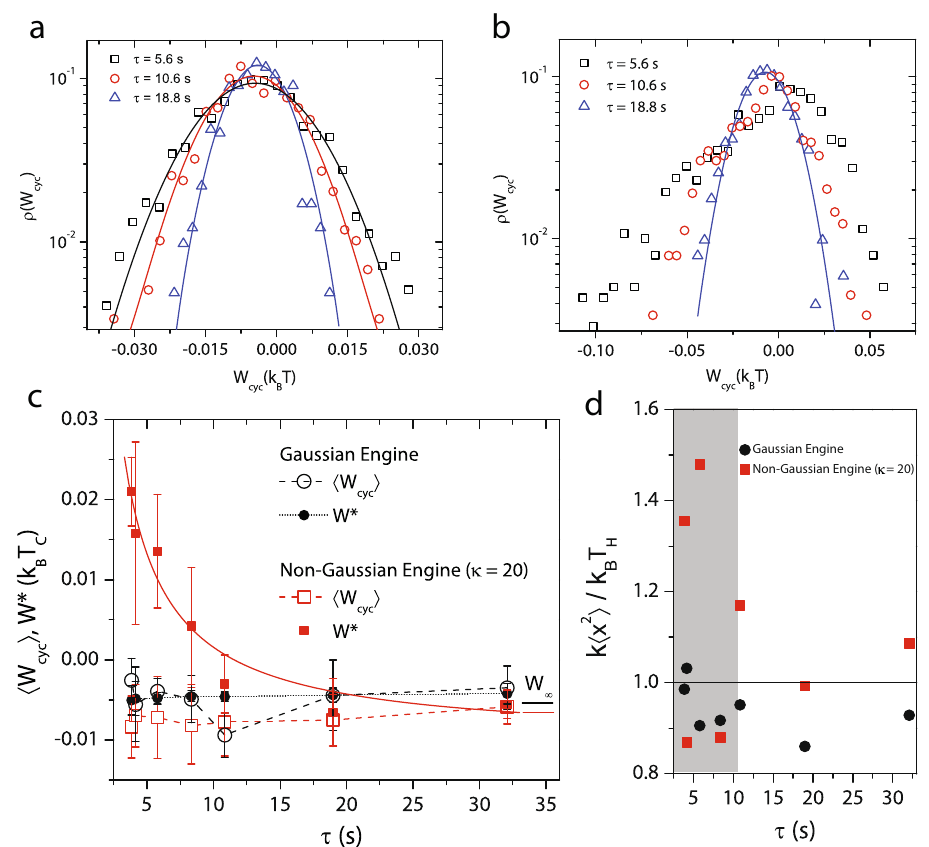
Fig. 2 Buildup of irreversibility in the non-Gaussian Stirling engine at fi nite τ . In a and b , we show probability distribution of work done per cycle ρ ( W cyc ) for the Gaussian engine and for the non-Gaussian engine with κ = 20 in the hot reservoir, respectively, for different cycle durations. τ = 18.8 s (blue triangles), τ = 10.6 s (red circles), and τ = 5.6 s (black squares). Solid lines represent corresponding Gaussian fi ts to the data. c Red hollow and solid squares show the average work done per cycle 〈 W cyc 〉 and the most-probable work W * , respectively, for the non-Gaussian engine with κ = 20 for the hot reservoir at various τ . The red solid line is a fi t to Eq. (1). Black hollow and solid circles show 〈 W cyc 〉 and W * respectively for the thermal/Gaussian engine. At large τ , the experimentally calculated work for these engines agrees with theoretically calculated quasistatic work W ∞ indicated by the small red horizontal line for the non-Gaussian engine with κ = 20 for the hot reservoir and by the black line for the Gaussian engine. Mean work 〈 W cyc 〉 is calculated for each realization of the engine over 450 cycles for τ = 3.7 s, 400 cycles for τ = 4 s, 278 cycles for τ = 5.6 s, 193 cycles for τ = 8 s, 150 cycles for τ = 10.6 s, 85 cycles for τ = 18.8 s and 50 cycles for τ = 32 s. d The ratio k h x 2 i = k B T H calculated at the midpoint of the hot isotherm for various τ is showed by the eff red squares for the non-Gaussian engine with κ = 20 in the hot reservoir and by the black circles for the Gaussian engine. The horizontal line indicates the equilibrium condition, which is violated inside the shaded gray region, in the case of the non-Gaussian engine with κ = 20 in the hot reservoir. The error bars indicate the standard deviations of the mean and the most probable quantities across different (cid:5) ð τ Þ probable power, P (cid:5) ð τ Þ ¼ (cid:4) W τ , for the Gaussian Stirling engine (circles) and for the non-Gaussian one with κ = 10 (triangles) and κ = 20 (squares) for the hot reservoir, respectively. Since for the Gaussian engine, over the range of τ studied Σ = 0, P * ( τ ) is same as P ( τ ) and only increases monotonically on lowering τ . Whereas